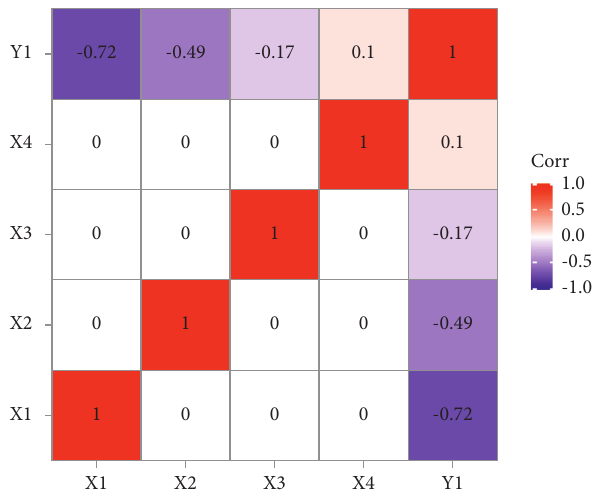
Figure 9: Heat map of the correlation between each factor and the compressive strength of the